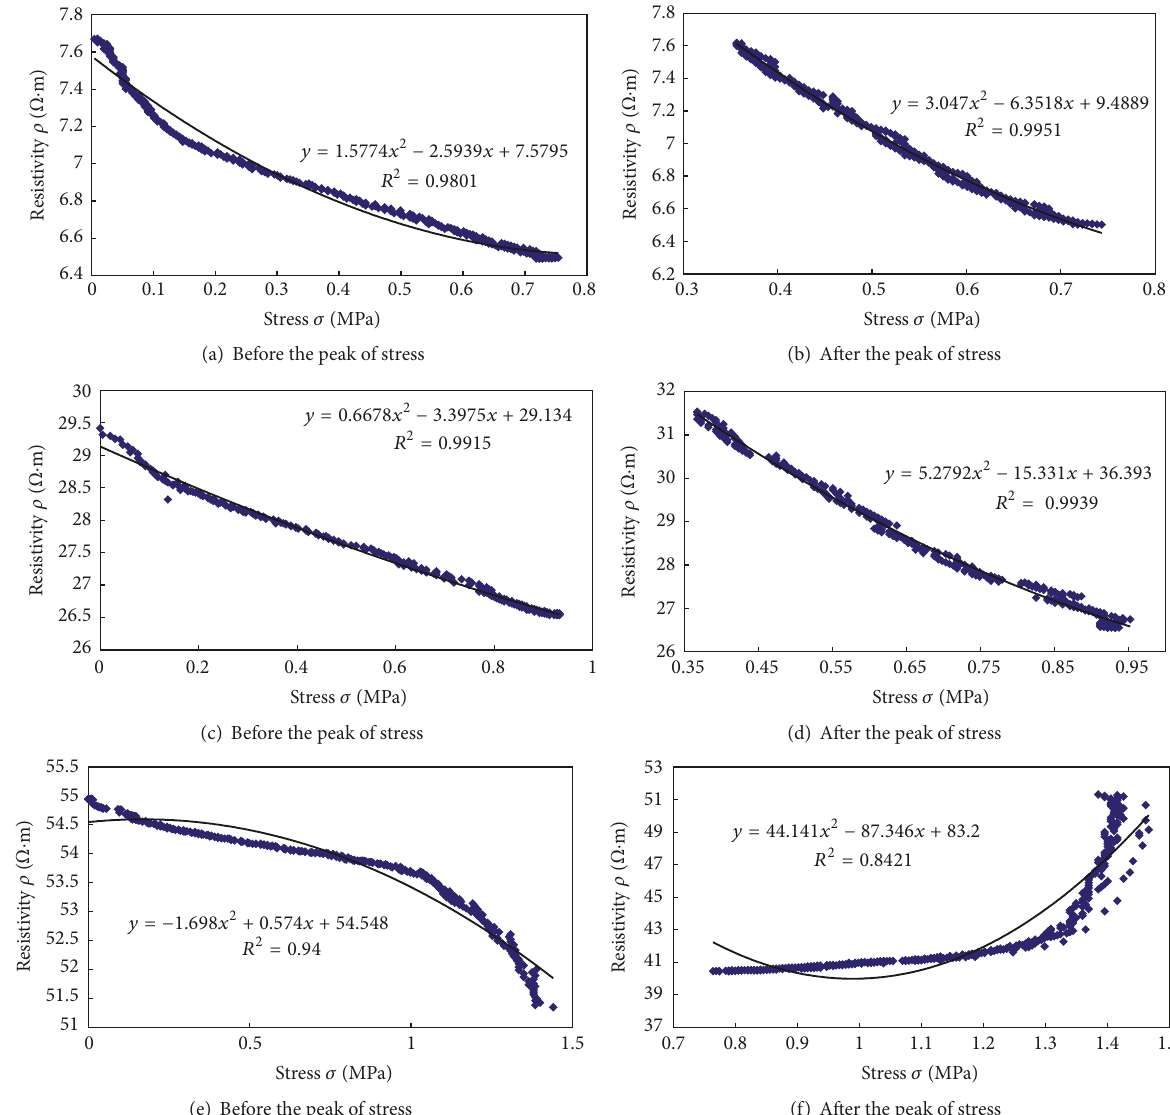
Figure 10: Relationship between stress and resistivity before and after the stress peak at 1 day (a, b), 3 days (c, d), and 7 days (e,